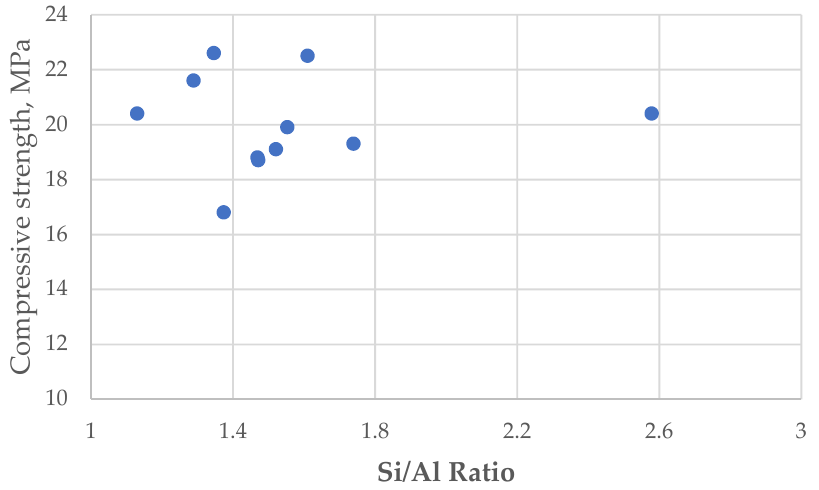
Figure 6. The influence of Si/Al rate in different experimental conditions on the the compressive strength of synthesized materials.